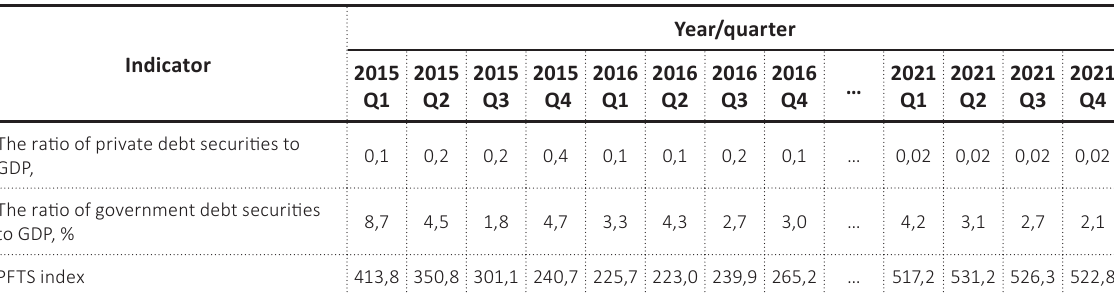
Table А7. Information base for the study of the stock market security in Ukraine